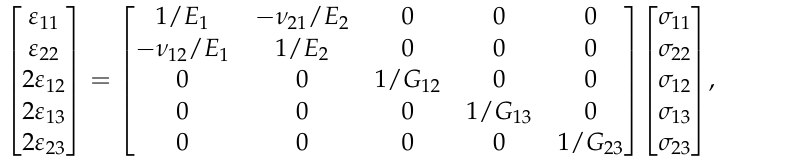
Table 1. Material data for orthotropic constitutive model of corrugated cardboard layers.